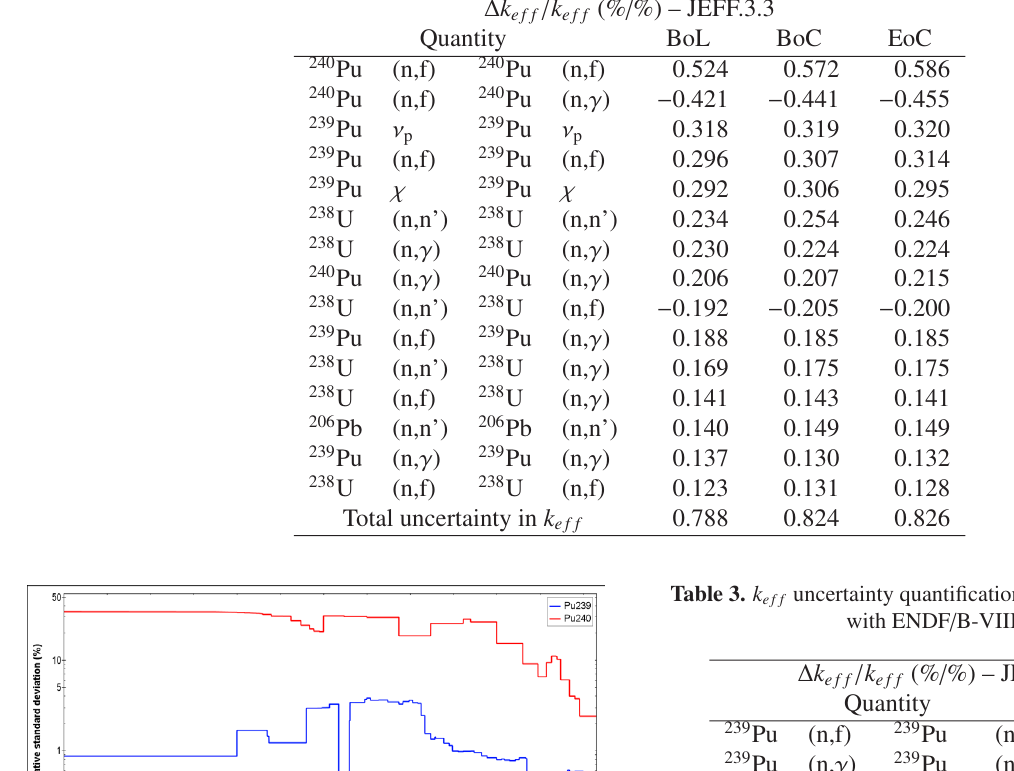
Table 1. Top 15 Integrated Sensitivity Coe ffi cients for ALFRED and di ff erent reactor cycles. The statistical uncertainty of the sensitivity coe ffi cients due to Monte Carlo calculations is 10 -5 .